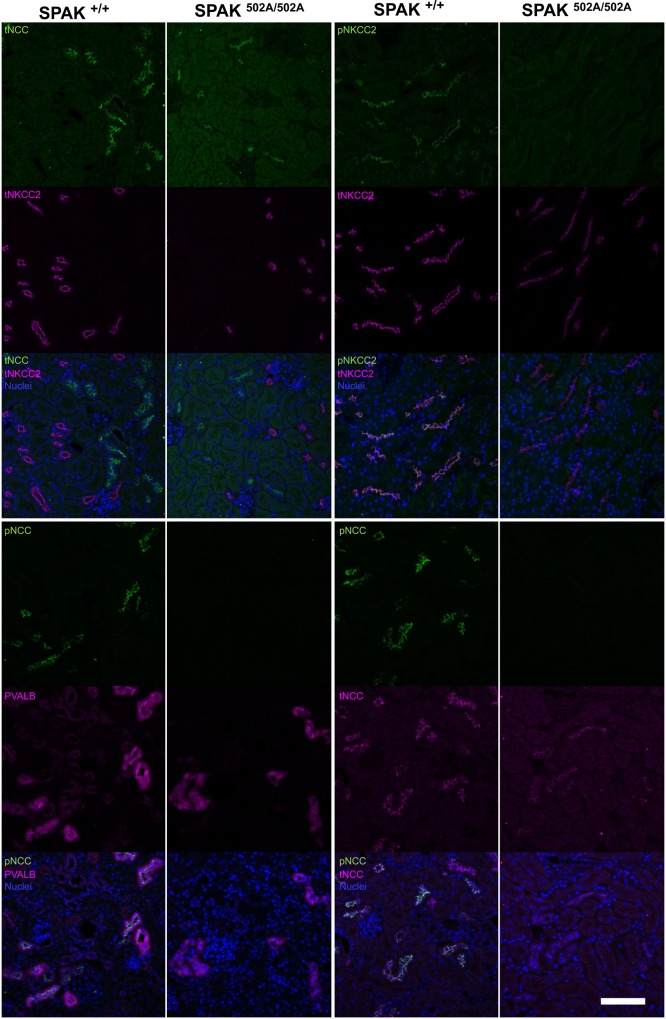
Immunolocalisation of NCC and NKCC2 in the renal tubules of SPAKL502A/L502A Mice. Representative pseudocoloured average intensity z projections of immunofluorescent-stained kidney sections (n = 4 per genotype) showing the distribution of total and phospho proteins in the TAL marked by total NKCC2 (tNKCC2), early distal convoluted tubule (DCT1) marked by parvalbumin (PVALB) and whole distal convoluted tubule (DCT1/2) marked by total NCC (tNCC). Phospho-NCC T46 (pNCC) and phospho-NKCC2 S91 (pNKCC2) are virtually undetectable in the SPAKL502A/L502A mice. Scale bar = 100 µm.